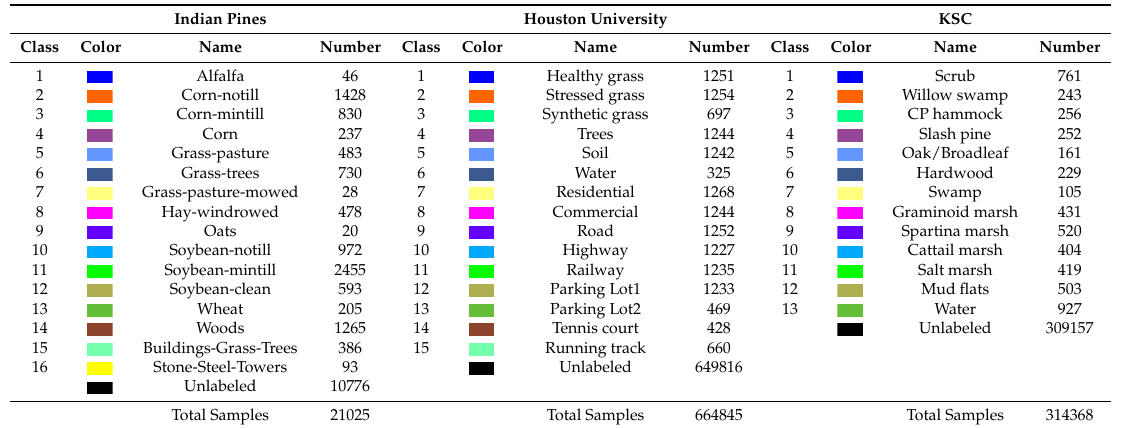
Table 2. Number of samples per class of the Indian Pines, Houston University, and Kennedy Space Center (KSC) data